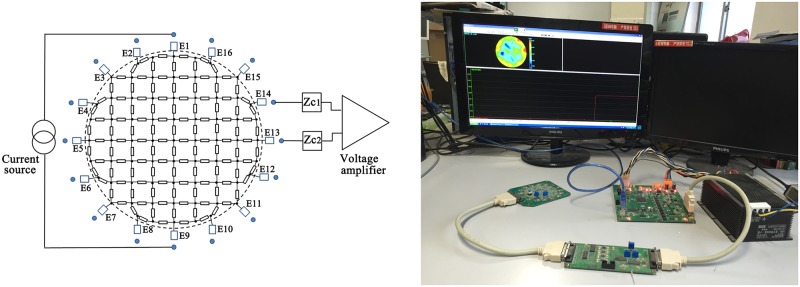
The circuit for assessing the effects of the contact impedance imbalance between two measuring electrodes, in which two resistors simulate the contact impedance.